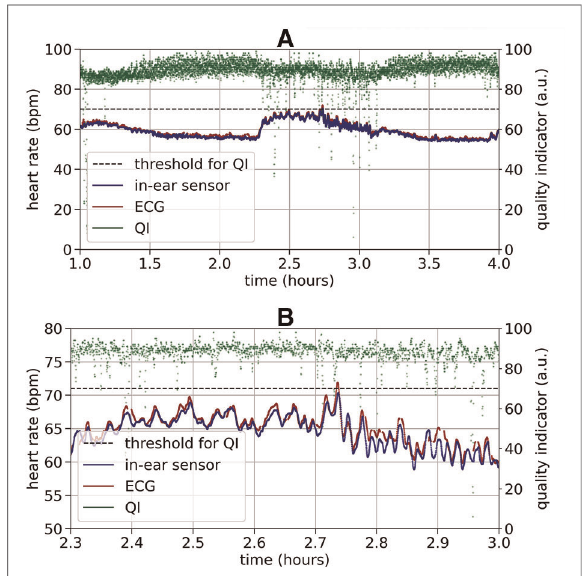
FIGURE 3 Top plot: Example of a high quality heart rate recording (bpm) over three hours by the ECG (red) and the in-ear sensor (blue). The signal quality indicator of the in-ear sensor (green) is above the quality threshold of 70 (indicated by the dashed line) at nearly all times of the recording. The heart rate data of the in-ear sensor and of the ECG overlap in a way that the red line of the ECG is completely hidden by the blue line of the in-ear sensor. Bottom plot: For better visibility this fi gure shows a short clipping of the recording above. During a period of relatively high variance in the heart rate, compared to the rest of the measurement, the heart rate values obtained by the ECG (red) and the in-ear sensor (blue) still show high agreement.